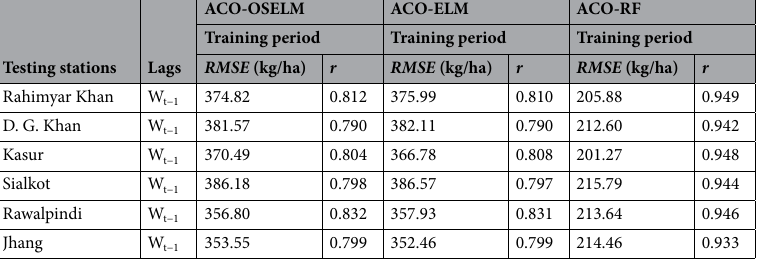
Table 4. Training performance of two-phase hybrid ant colony optimization algorithm coupled online sequential extreme learning machines (ACO-OSELM) versus ACO-ELM and ACO-RF models with correlation coefficient ( r ) and root mean squared error ( RMSE , kg ha −1 ).